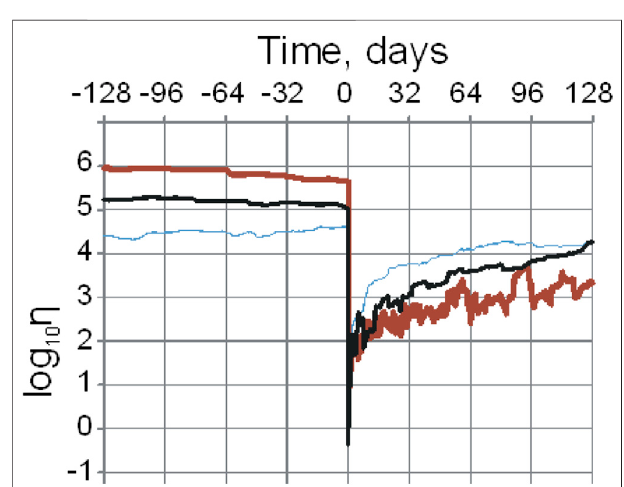
FIGURE7| Averages oftheUSLE control parameter η per 50events vs. time to the main shock for the M W 7.1 January 24, 2016 (thin blue line), M W 7.9 January 23, 2018 (heavy red line), and M W 7.1 November 30, 2018 (black line) major